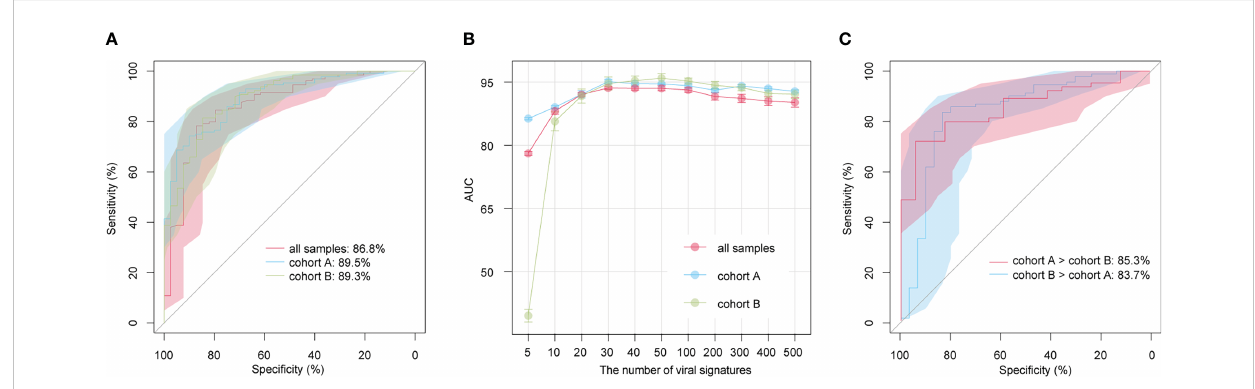
FIGURE 5 Prediction models of AS status based on gut viral signatures. (A) Receiver operating characteristic (ROC) analysis of the classi fi cation of disease/ control status using the random forest algorithm. (B) Average AUC values for different numbers of AS-associated vOTUs. (C) ROC analysis of the classi fi cation of disease/control status in cross-cohort models.